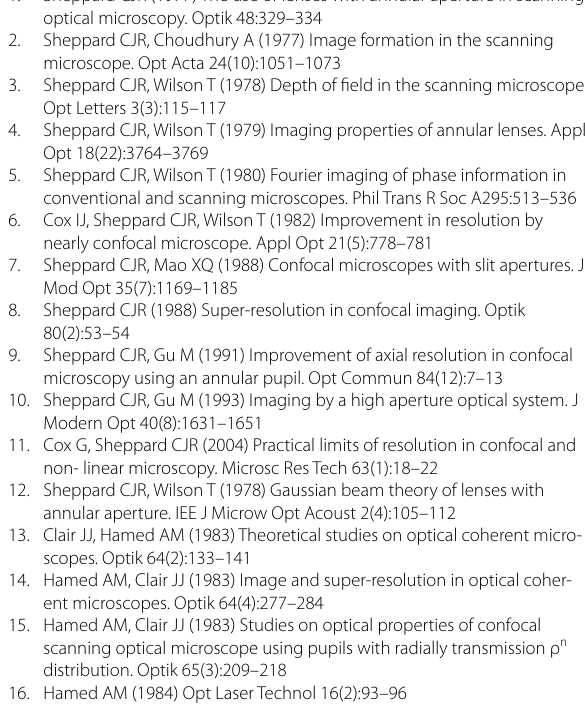
0.5039 µm as shown in the =